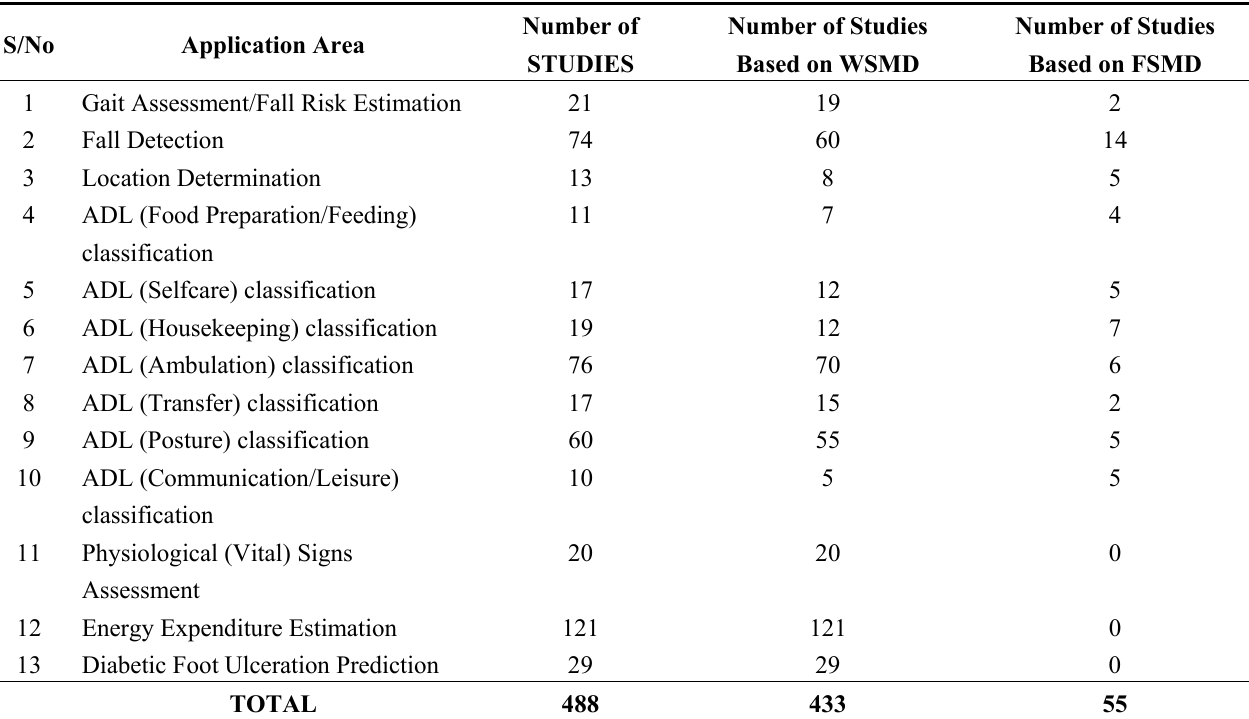
Table 2. Distribution of existing